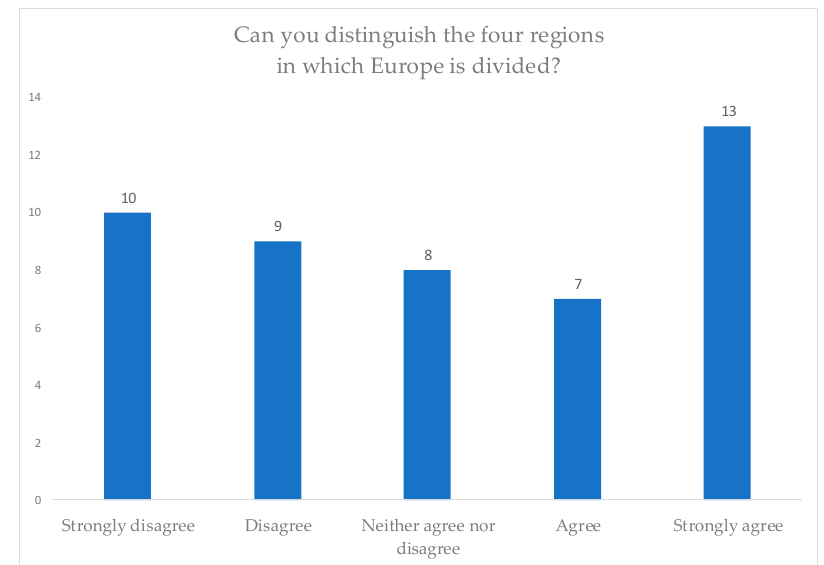
Figure 11. Self-reported comparison between conventional and Game-Based Learning (GBL).